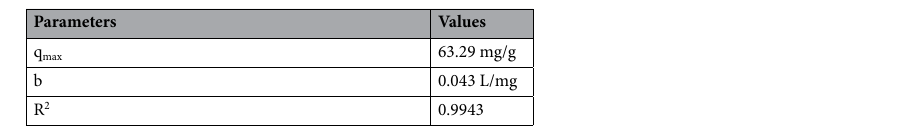
Table 2. Adsorption isotherm parameters for Cu(II) ions adsorption onto Cs-g-PVP/f-MWCNTs (hybrid II) surface adsorbent.